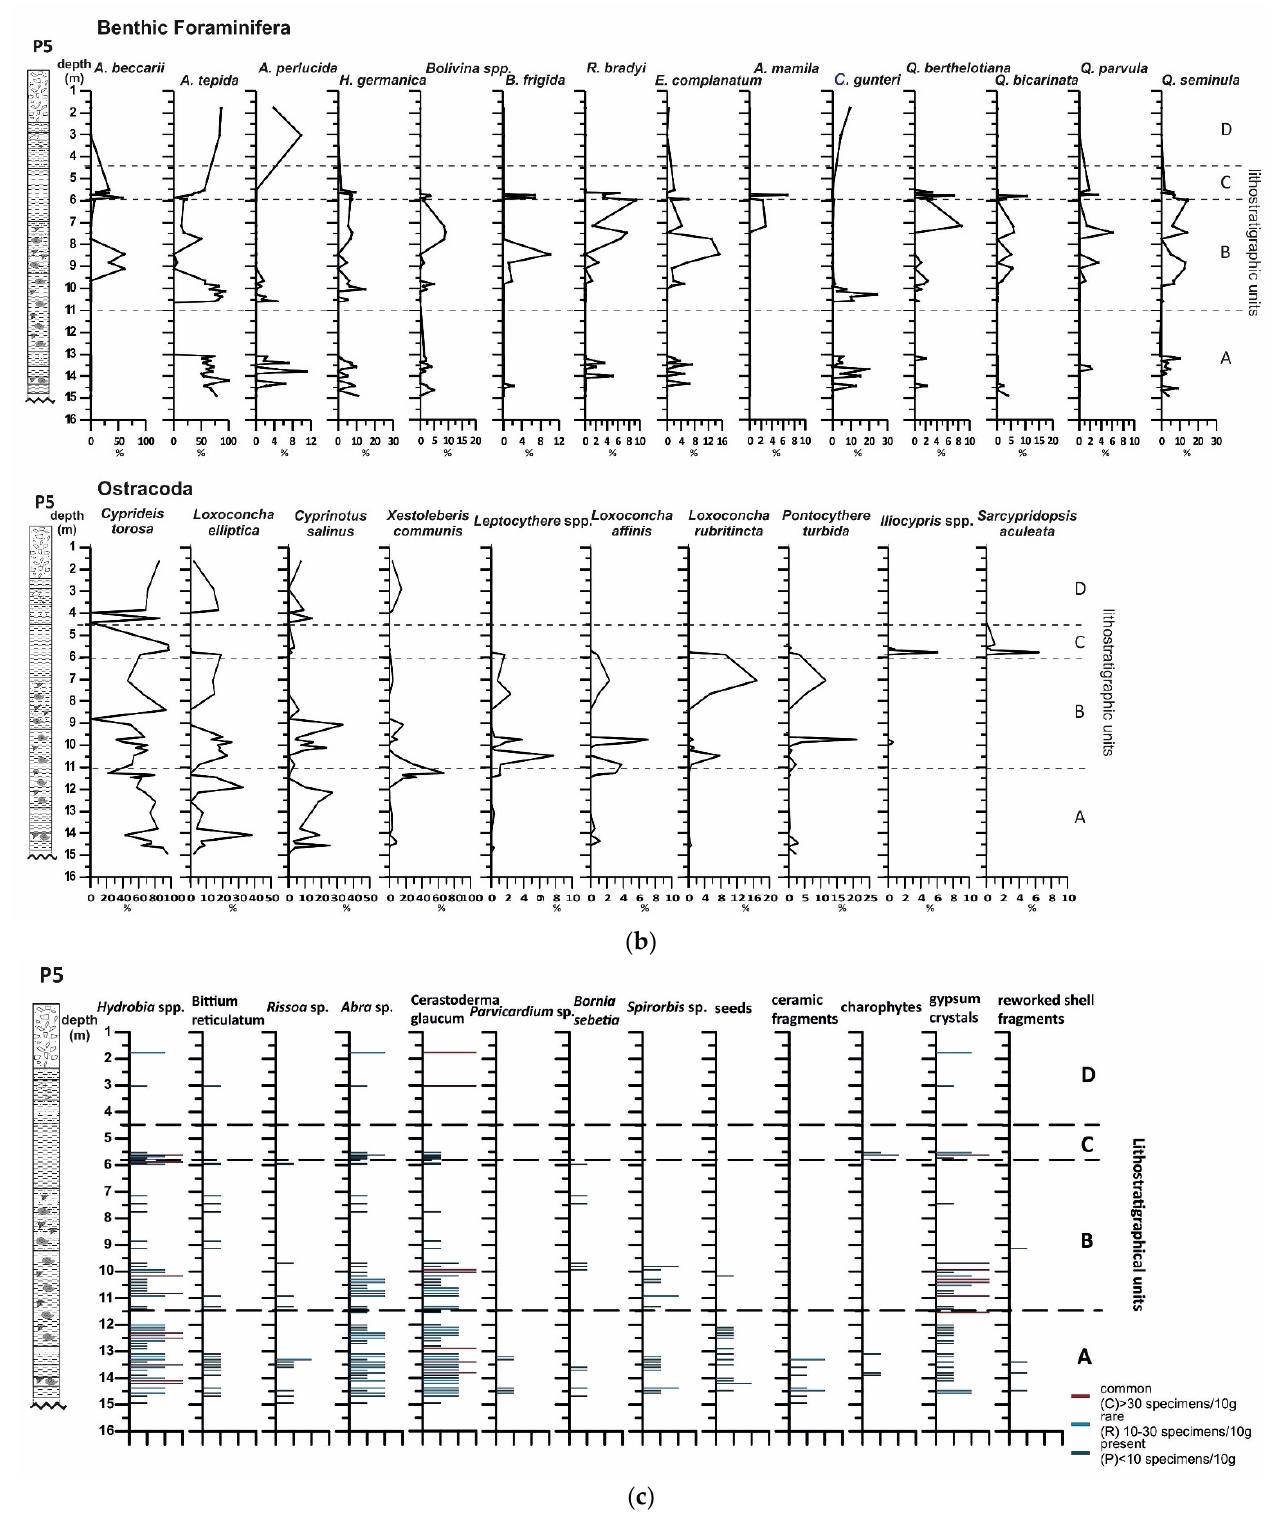
Figure 5. ( a ) Distribution of foraminiferal and ostracod indices along borehole P4 in respect to lithostratigraphic units; ( b ) Relative abundances of the major benthic foraminiferal and ostracod species in borehole P5; ( c ) Distribution and semiquantitative analysis of the main mollusc taxa and other microscopic findings in borehole P5. Lithostratigraphic units (A–D) are separated by dotted lines.